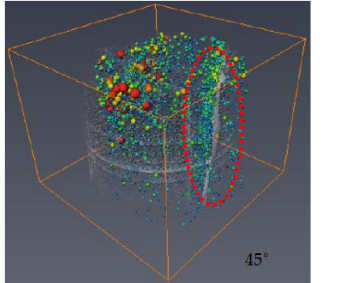
Figure 11. Spatial distribution of large-size mineral particles.